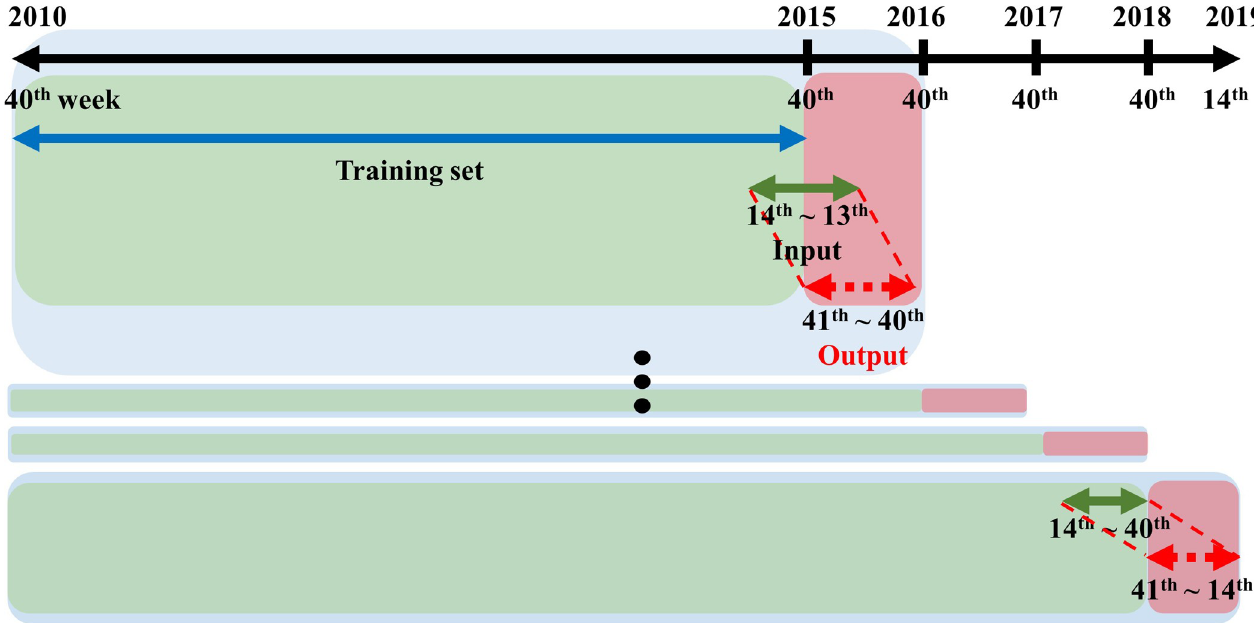
Fig 4. The explanation for the training set at the 40 th week and output for forecasting seasonal influenza after 26 weeks. https://doi.org/10.1371/journal.pone.0220423.g004 GT with the keyword “influenza A virus” in Australia and Chile showed high correlation coef- ficients with -23 and -30 week time lags, respectively. The correlation coefficient for the ILI of temperature in the U.S. was more than 0.7 with a -27 week time lag.